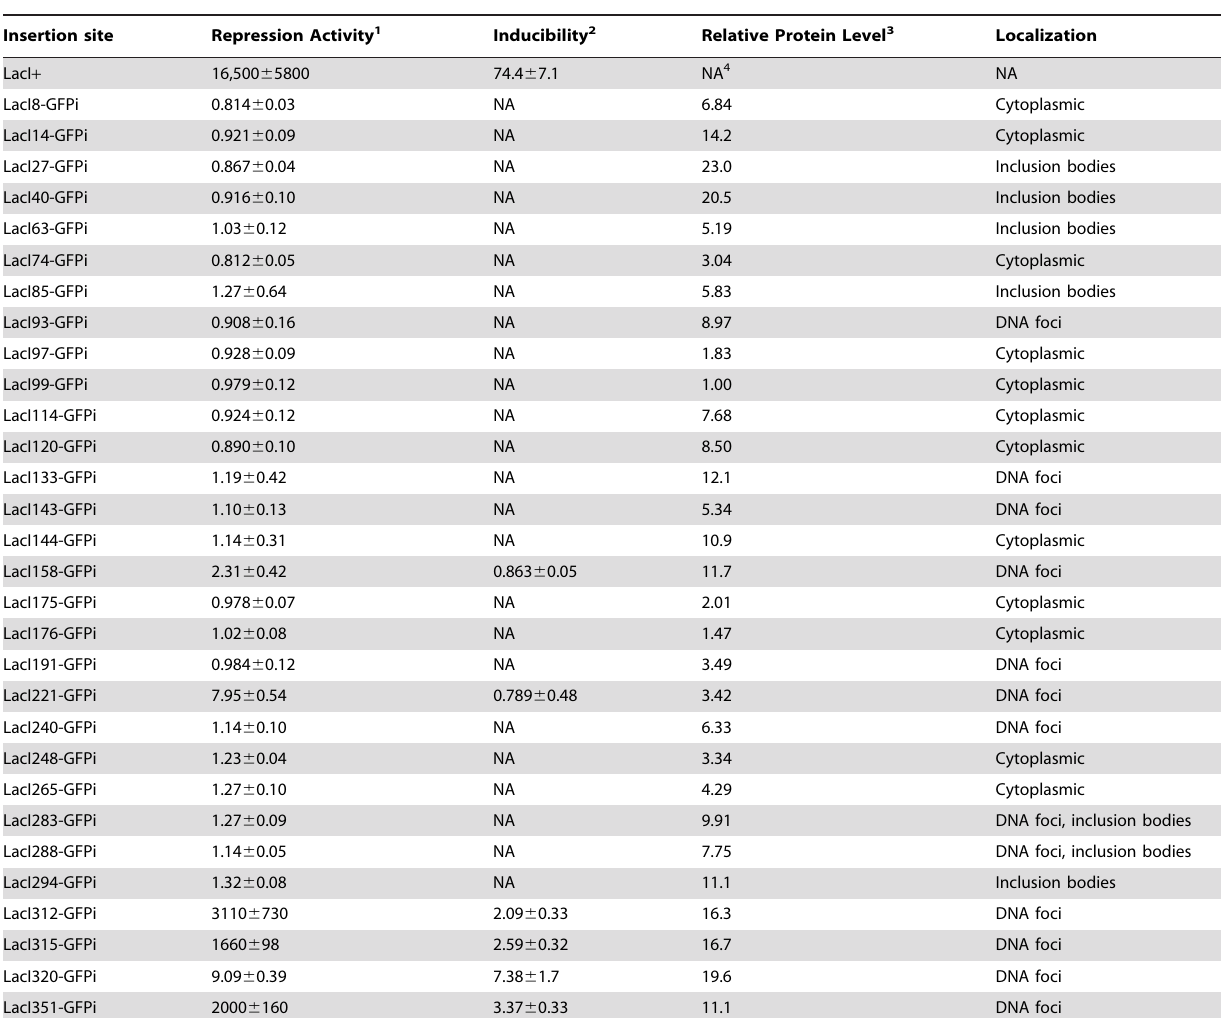
Table 1. In vivo activities and accumulation of LacI-GFP insertion proteins.